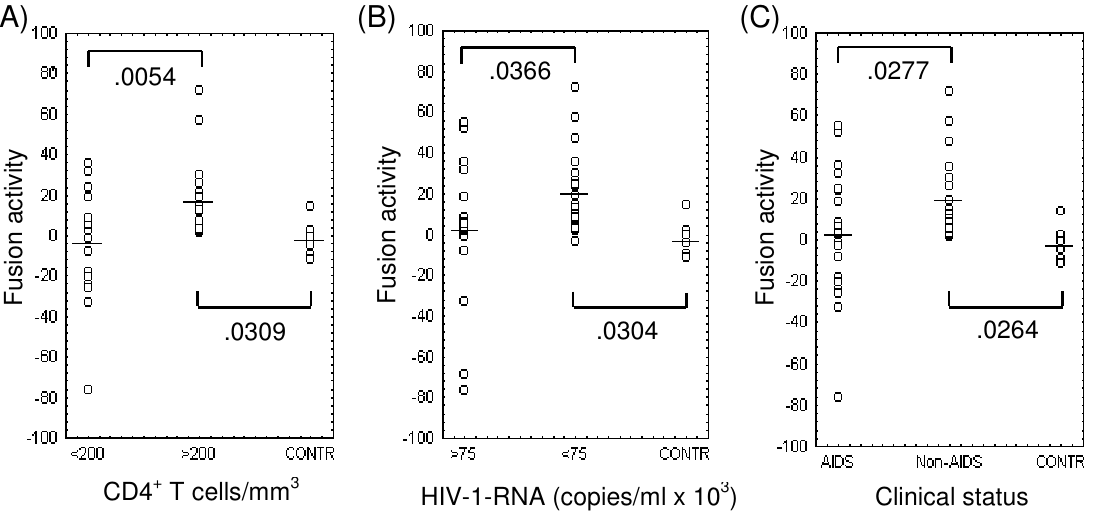
FIGURE 11 . Relationship of sera activity on fusion with CD4 + lymphocyte count (A), viral load (B), and clinical status (C). Values of fusion activity greater and lower than zero indicate inhibition or enhancement of fusion, respectively. Probability values ( p ) for significant differences are shown. Dilution of sera was 1:50. CONTR: HIV-negative controls. (Reprinted from Huerta et al.[103]. Copyright 2005, with permission from the Society for General